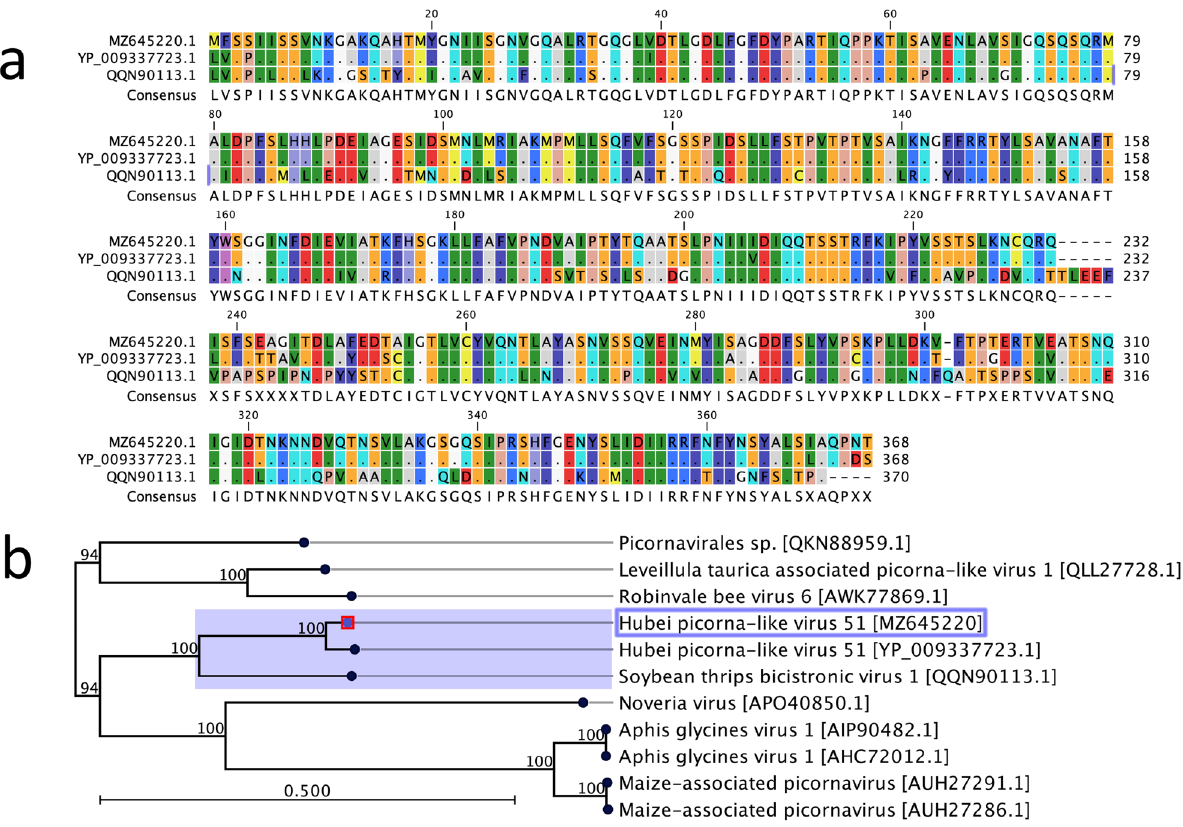
Figure 3. Comparison of picorna-like virus detected in this study (GenBank accession no. MZ645220) with other selected picorna-like viruses of the family Picornaviridae . ( a ) Multiple alignments of the selected amino acid sequences were performed using tools available in CLC Genomics Workbench (version 9.5.4), where dots represent those amino acids identical to the picorna-like virus detected in this study. ( b ) A maximum likelihood (ML) tree was constructed by using selected amino acid sequences of the partial hypothetical protein 1 gene of Hubei picorna-like virus. The ML tree was constructed under the WAG substitution model, and 1000 bootstrap replicates using tools available in CLC Genomics Workbench (version 9.5.4). The numbers on the left show bootstrap values as percentages, and the labels at branch tips refer to original picorna virus names, followed by GenBank accession numbers in parentheses. The clade correspondence to the picorna-like virus sequence from this study is highlighted in purple, and the picorna-like virus sequenced in this study is shown in the purple